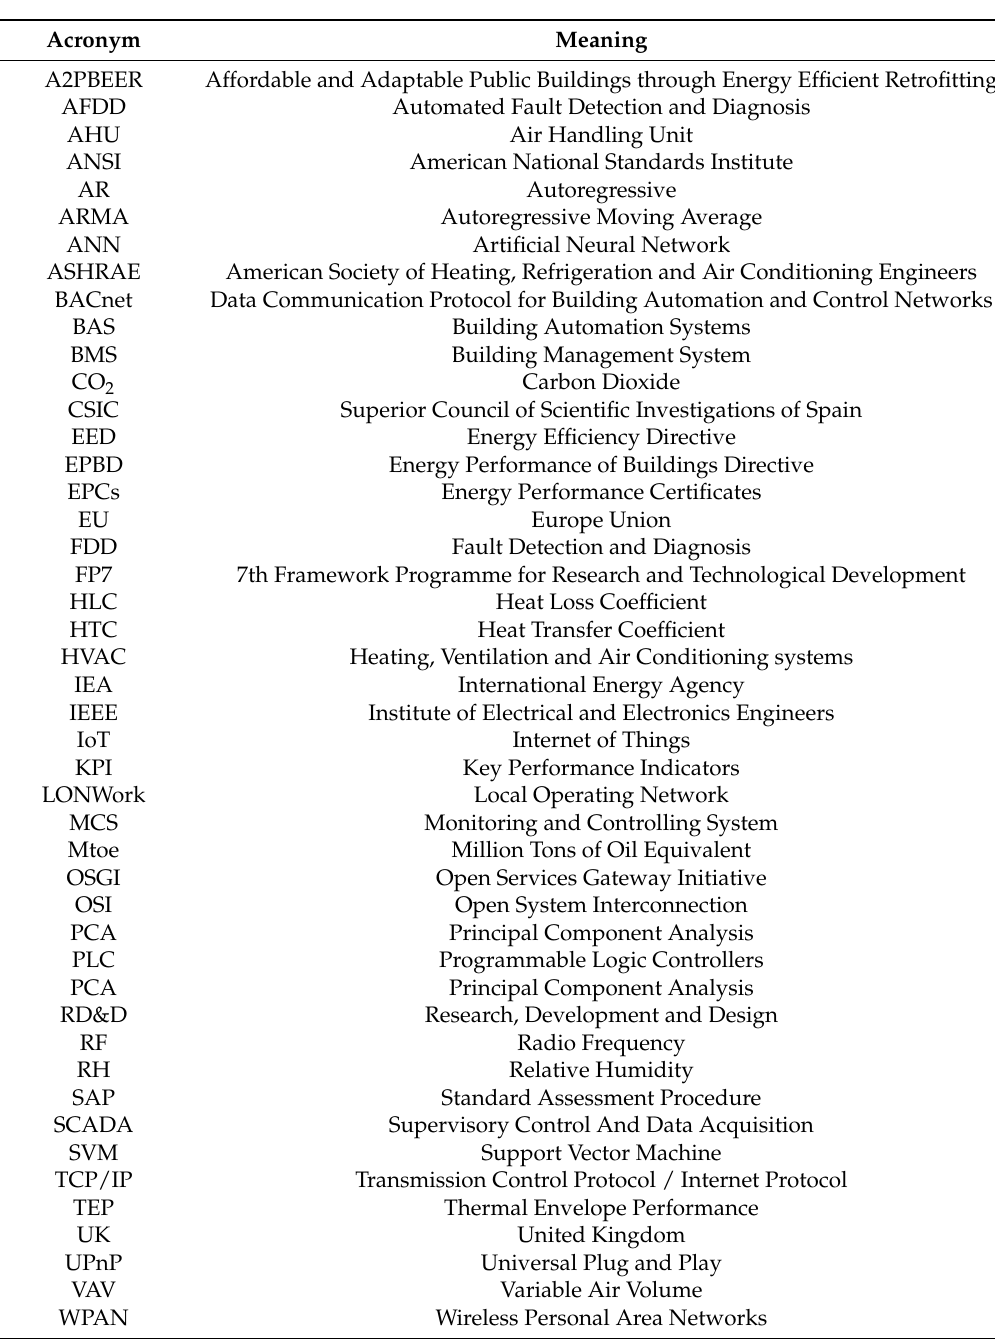
Table A1. Acronyms